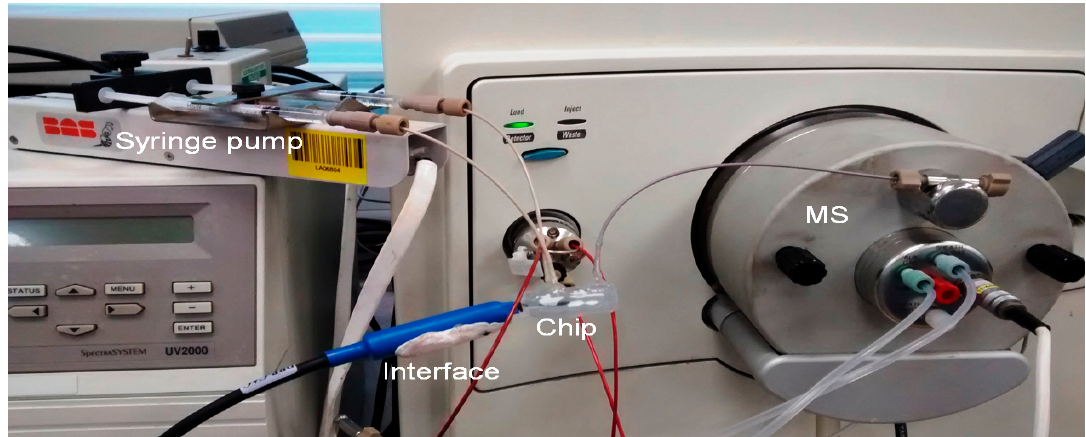
Figure 3. Online coupling of chip with electrospray ionization/mass spectrometry (ESI/MS).